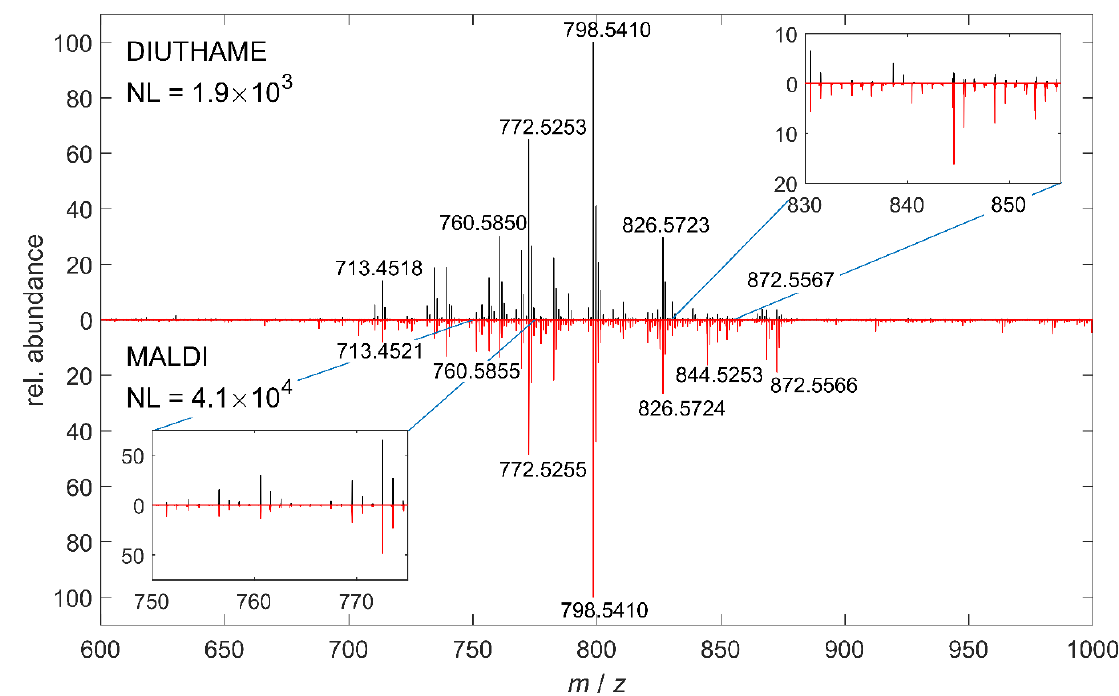
Figure 2. Comparison of 100 summed mass spectra acquired by DIUTHAME (black) and MALDI (red) MSI, respectively, from adjacent mouse brain tissue sections in the cerebellum region in positive-ion mode.